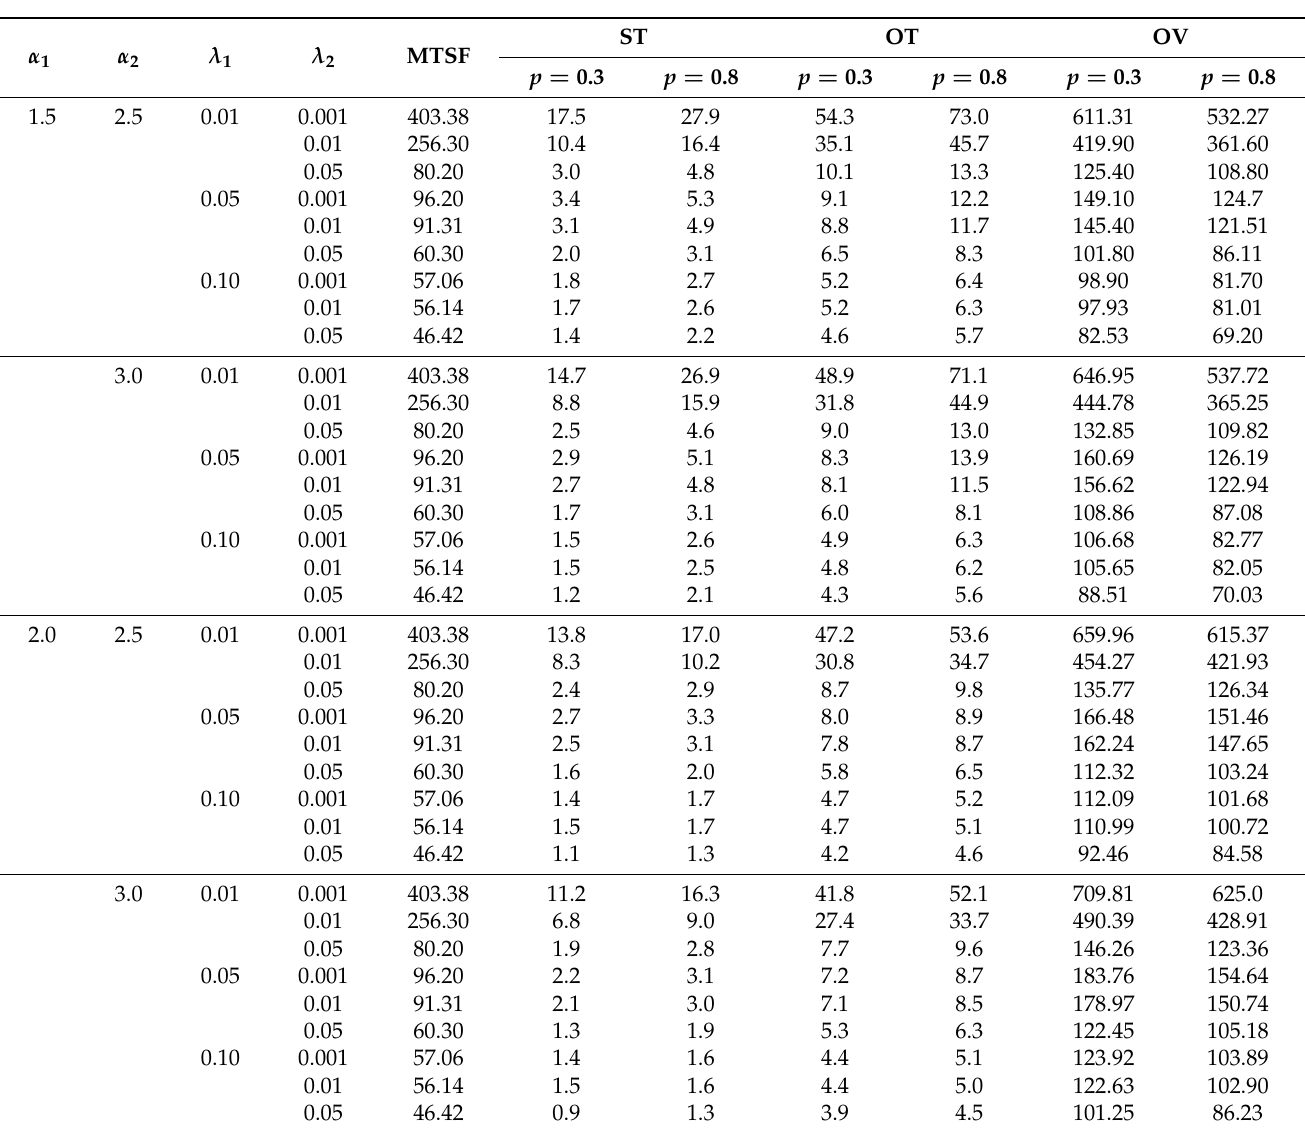
Table 1. MTSF without PM at the starting time (ST) and the optimal time (OT) of t 0 with the corresponding optimal value of MTSF ( t 0 ) (OV) to perform PM when ν = 0.5, δ = 1, λ 3 = 0.3, λ 4 =